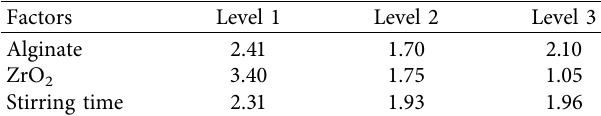
Table 2: Te main efects of diferent levels of alginate, ZrO the stirring time on the survival rate of Streptococcus